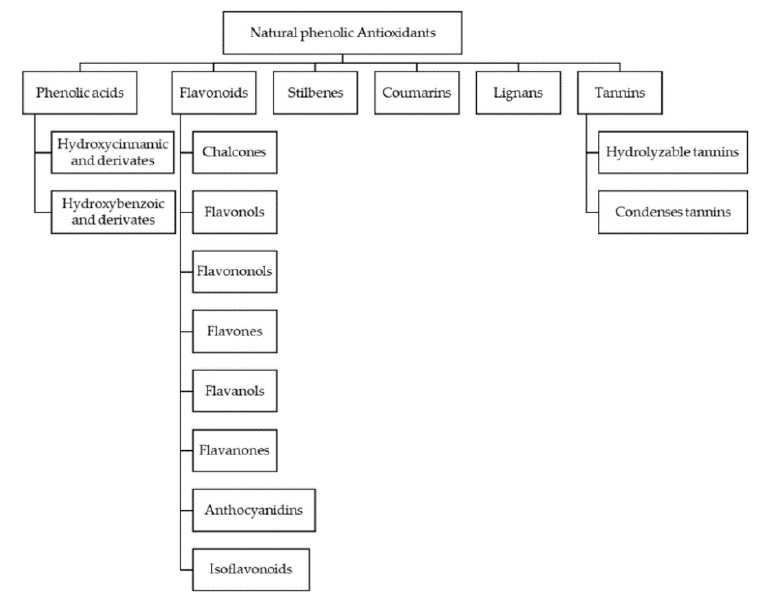
Figure 1. Natural phenolic compound classification [8].